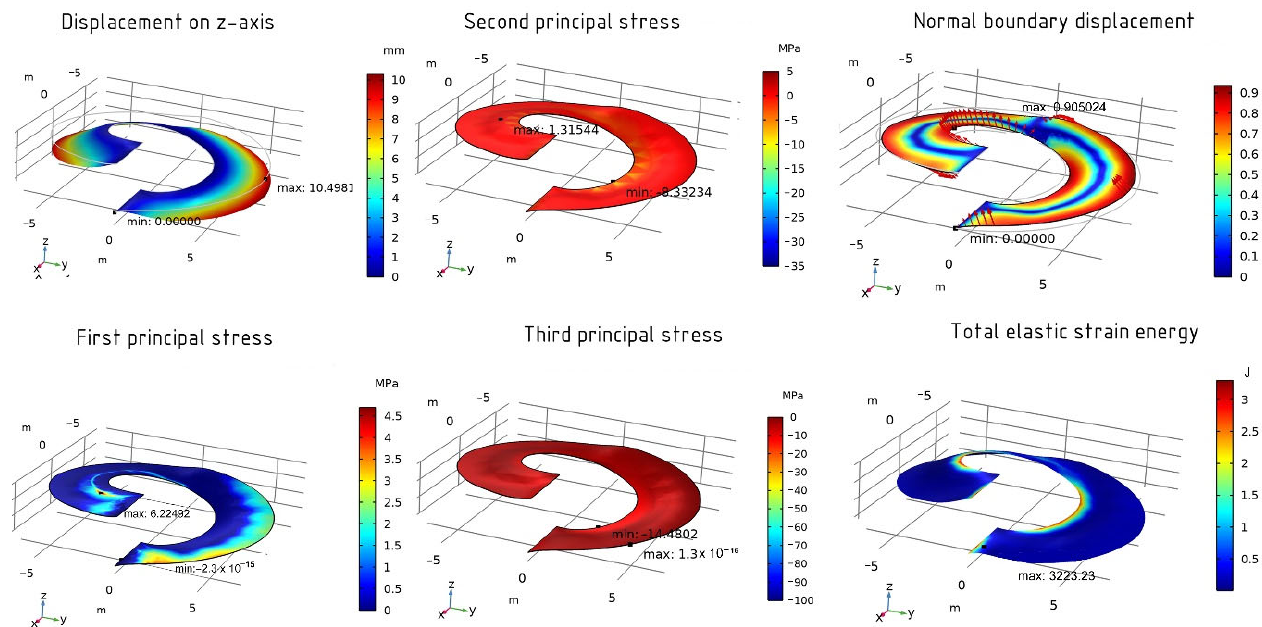
Figure 21. The results of the optimized shell using the SNOPT method. For the optimized shell using the IPOPT method on the z ‐ axis, the maximum dis ‐ placement value is 10.6 mm. The values of the first principal stress are 6.15 MPa (maxi ‐ mum) and − 1.6 × 10 − 15 MPa (minimum). For the second principal stress, the maximum value is 1.27 MPa and the minimum value is − 8.38 MPa. The values of the third principal stress are 4.3 × 10 − 16 MPa (maximum) and − 14.62 MPa (minimum). The normal boundary displacement for the optimized shell is 90% and the total elastic strain energy is 3223 J.